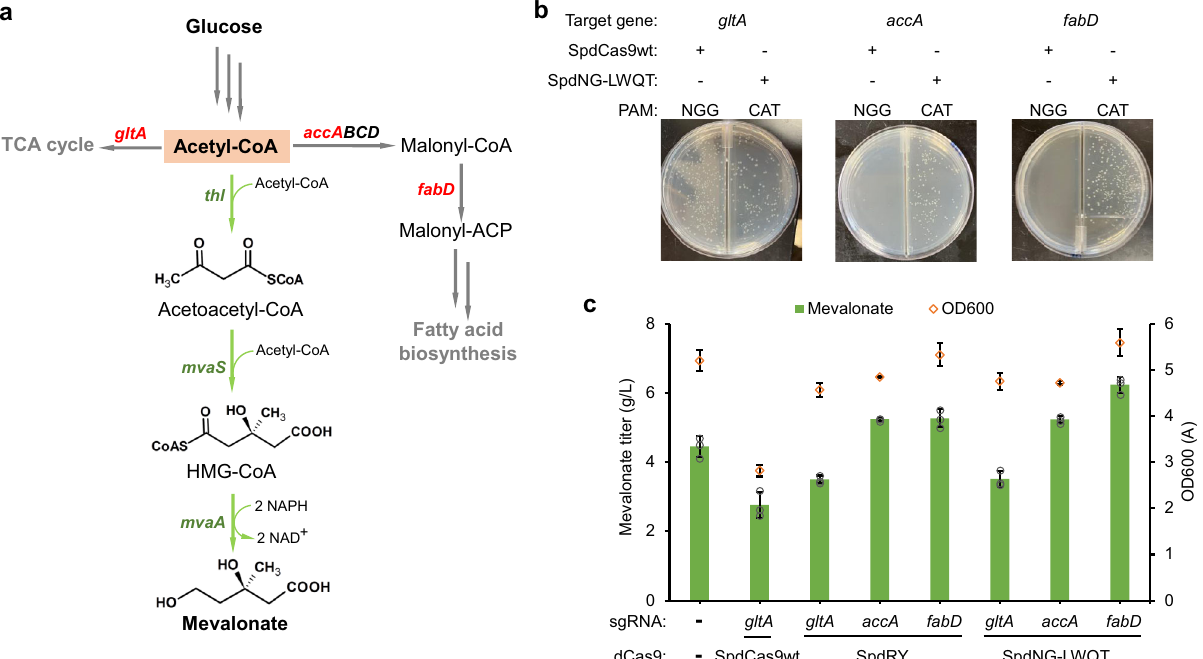
Fig. 6 Production enhancement of mevalonate via SpdNG-LWQT mediated CRISPR interference (CRISPRi). a The metabolic pathway of mevalonate from glucose. The pathway consists of three enzymes: thiolase ( thl ) from C. dif fi cile , 3-hydroxy-3-methyl-glutaryl-coenzyme A (HMG-CoA) synthase ( mvaS ) from L. casei , and HMG-CoA reductase ( mvaA ) from R. pomeroyi . Three competing essential genes (shown in red) from E. coli are: gltA encoding citrate synthase, accA encoding the subunit α of acetyl-CoA carboxyltransferase, and fabD encoding malonyl-CoA-acyl carrier protein transacylase. b The in fl uence of CRISPRi of gltA , accA , or fabD on cell fi tness of E. coli BW25113(F ′ )::MVA. The dCas9s were expressed on pCS27, and sgRNAs were expressed on pZE12-luc. All sgRNAs were targeting coding sequence on nontemplate DNA strand. SpdCas9wt was coexpressed with sgRNAs targeting 5 ′ -NGG-3 ′ PAM while SpdRY and SpdNG-LWQT were coexpressed with sgRNAs targeting 5 ′ -CAT-3 ′ PAM at the ATG start codons. Cells were plated on Luria- Bertani (LB) plates containing 0.5 mM IPTG and appropriate antibiotics. Representative image from two independent repeats. c The effects of SpdCas9wt or its variants mediated CRISPRi on mevalonate production in E. coli host BW25113(F ′ )::MVA. The host strain with empty pCS27 and pZE12-luc was applied as a negative control (NC). All shake fl asks were performed in M9 minimal medium containing 20 g/L glucose and 5 g/L yeast extract, and samples were taken at 48 h. Data indicated the mean ± standard deviation ( n = 3 independent biological replicates). Source data are provided as a Source Data fi